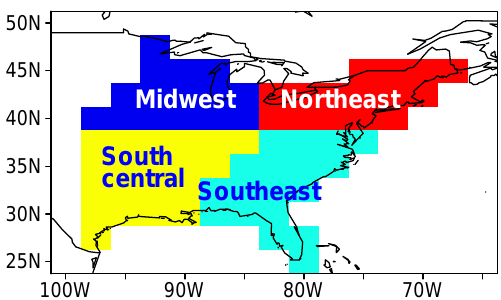
Figure 2. US regions used to study the variability of JJA surface ozone over